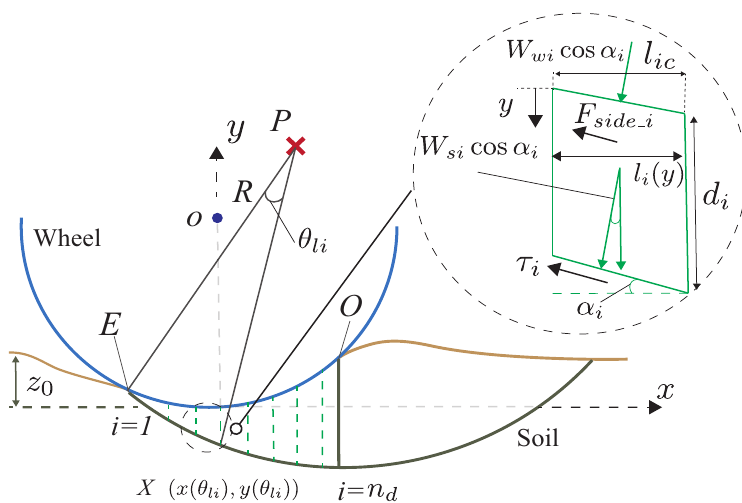
Figure 18. Force acting on each soil wedge beneath the